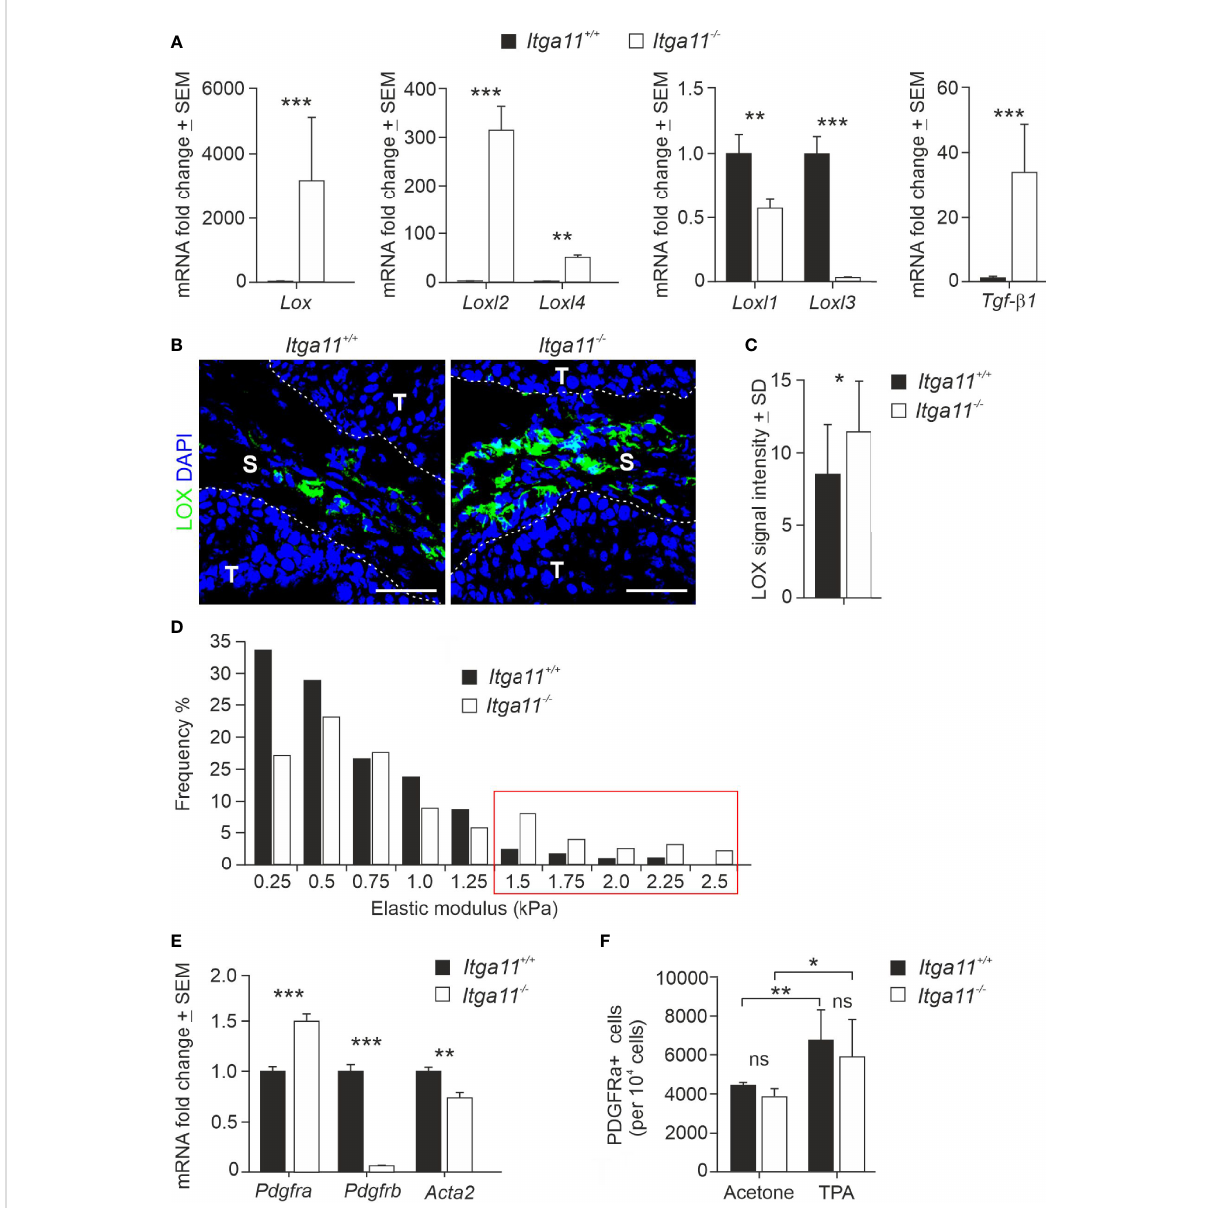
FIGURE 5 Expression of LOX family members and CAF markers in Itga11 − / − skin tumors. (A) RT-qPCR analysis of lysyl oxidase ( Lox ), LOX-like enzymes ( Loxl1-4 ), and transforming growth factor beta-1 ( Tgf b 1 ) in Itga11 +/+ and Itga11 -/- skin papillomas at week 20. The data are an average of ten samples (from different individuals) per genotype and normalized with endogenous Gapdh . (B) Representative immuno fl uorescence staining of LOX in Itga11 +/+ and Itga11 -/- papillomas. LOX signals are prominent in a 11-de fi cient skin tumors and widely distributed within the tumor stroma. Scale bars, 50 m m. S, stroma; T, tumor. (C) Quanti fi cation of LOX immuno fl uorescence in Itga11 +/+ and Itga11 -/- papillomas. Twelve to 15 images from fi ve tumors from fi ve different individuals/genotype were quanti fi ed using Fiji ImageJ analysis software. (D) Tumor stiffness measurements by atomic force microscopy. Histograms of the Young ’ s elastic modulus (kPa) of the Itga11 +/+ (n = 4) and Itga11 -/- (n = 3) papillomas collected at weeks 20 – 25. (E) RT-qPCR analysis of fi broblast markers PDGFR a , PDGFR b , and a SMA ( Acta2 ) in Itga11 +/+ and Itga11 -/- papillomas collected at week 20. Data are an average of ten samples (from different individuals) per genotype. Values were normalized with Gapdh . (F) Numbers of Lin - PDGFR a + cells in the acetone-treated normal and TPA-treated hyperplastic skin of the Itga11 +/+ and Itga11 -/- mice. In (A, C, E, F) *, p<0.05, **, p<0.01, ***, p<0.001. ns, not signi fi